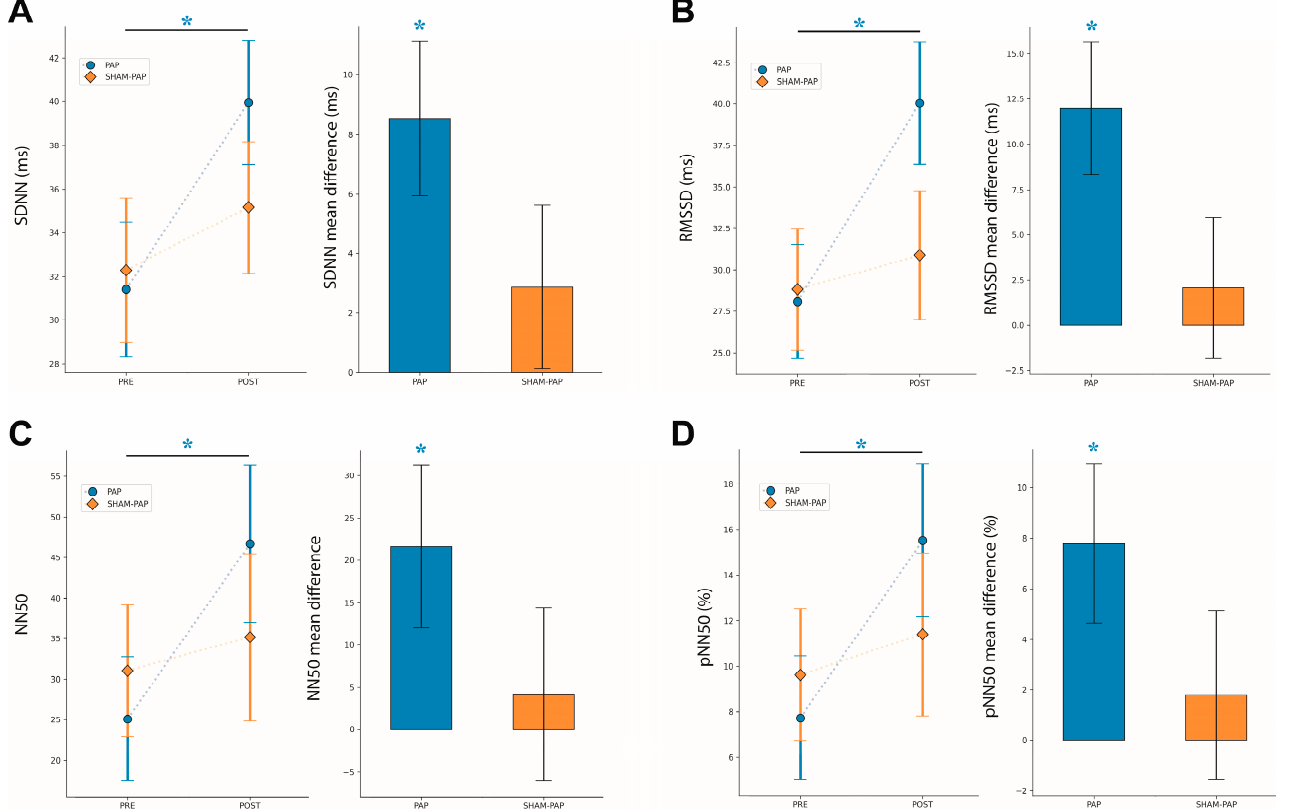
Figure 4. Frequency-domain parameter of HRV at rest, pre- and post-treatment. HF band. Data pre- sented are mean ± standard errors of the mean (SEM). Asterisk marks a significant difference ( p < 0.05).